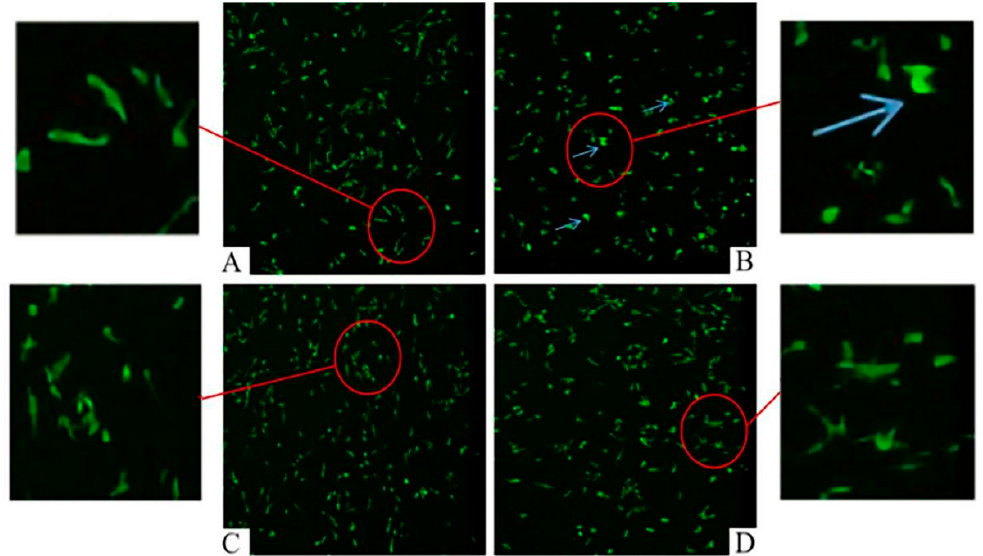
Figure 3. Effect of AT on membrane ruffling in C48/80-stimulated RBL-2H3 cells. ( A ). Normal RBL-2H3 cells; ( B ). C48/80-stimulated RBL-2H3 cells; ( C , D ). Effect of treatment with AT (between 30 and 60 µ M) C48/80-sensitized RBL-2H3 cells, n =